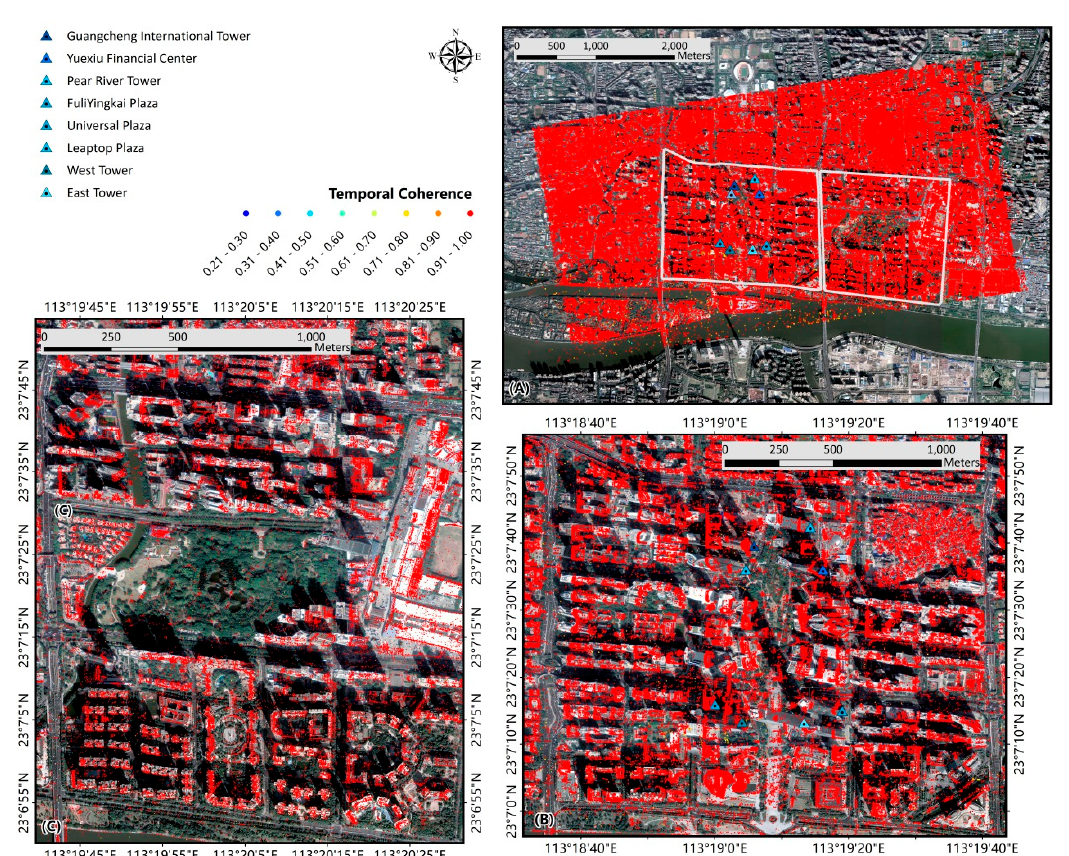
Figure 10. Temporal coherence map of the selected PSC in the standard processing result: ( A ) The whole study area ( B ) Subset of the map in test region A ( C ) Subset of the map in test region B.